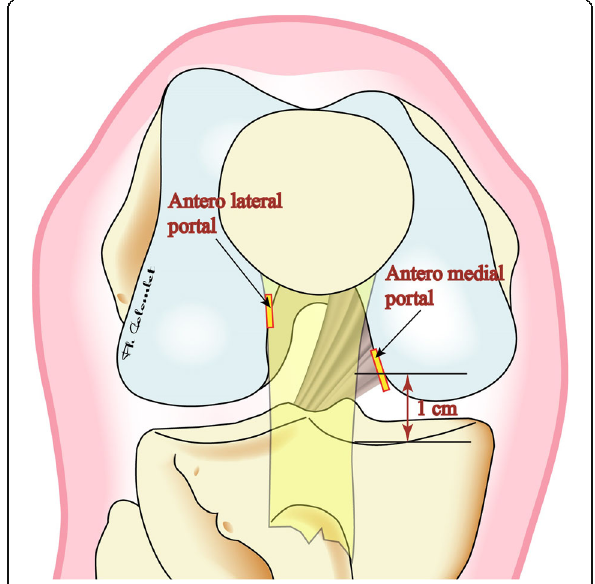
Fig. 1 Picture showing the position of anteromedial and anterolateral portals. The anterolateral approach is proximal and close to the patellar tendon. The anteromedial approach is flush with the femoral medial condyle one centimeter above the tibial plateau